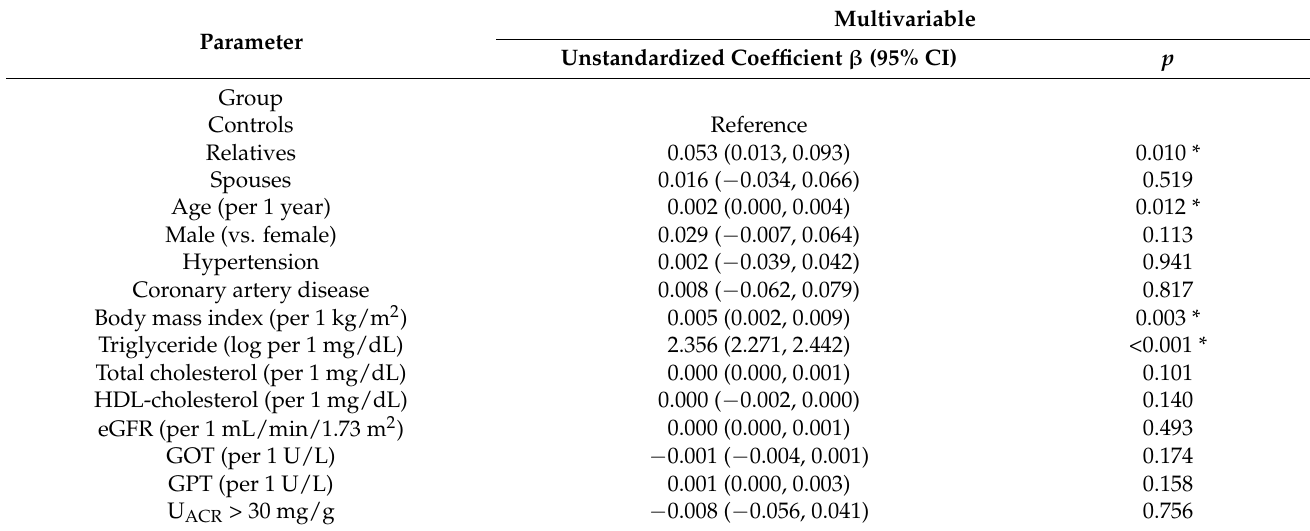
Table 3. Determinants of TyG index using multivariable linear regression